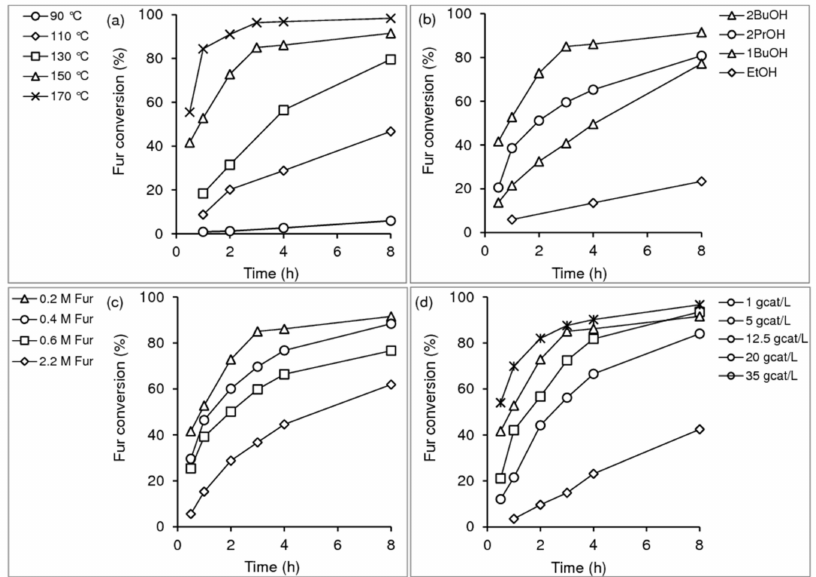
Figure 4. Influence of the reaction temperature ( a ), type of solvent ( b ), initial Fur concentration ( c ), and catalyst dosage ( d ) on the conversion of Fur in the presence of Hf-TUD-1(50). Reaction conditions: ( a ) 0.2 M Fur in 2BuOH, 20 g cat L − 1 ; ( b ) 0.2 M Fur, 20 g cat L − 1 , 150 ◦ C; ( c ) 2BuOH, 20 g cat L − 1 , 150 ◦ C; ( d ) 0.2 M Fur in 2BuOH, 150 ◦ C. Results up to 72 h are given in the Supplementary